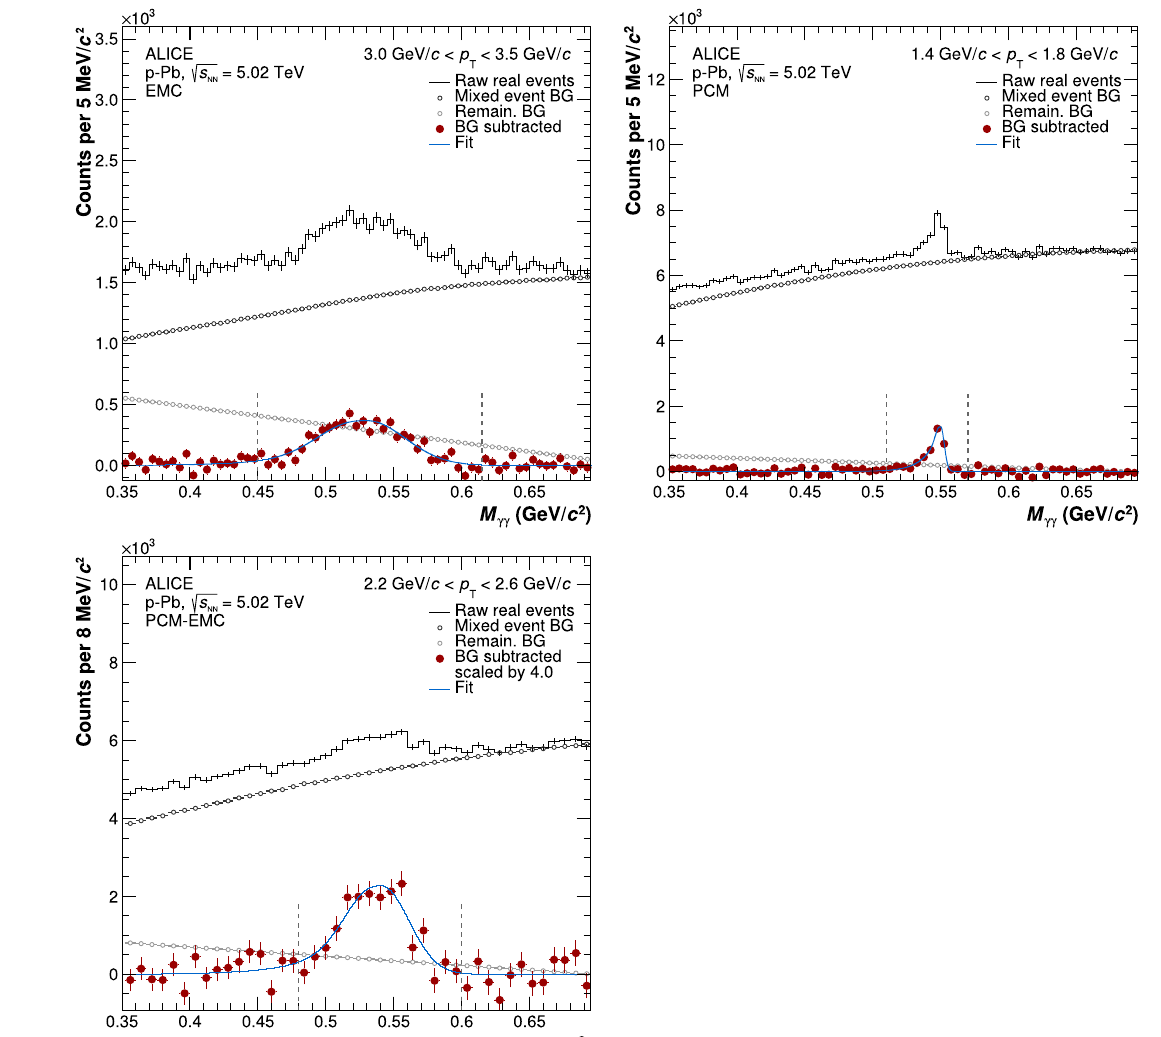
vertical lines correspond to the limits of the region used to compute the integration of the meson